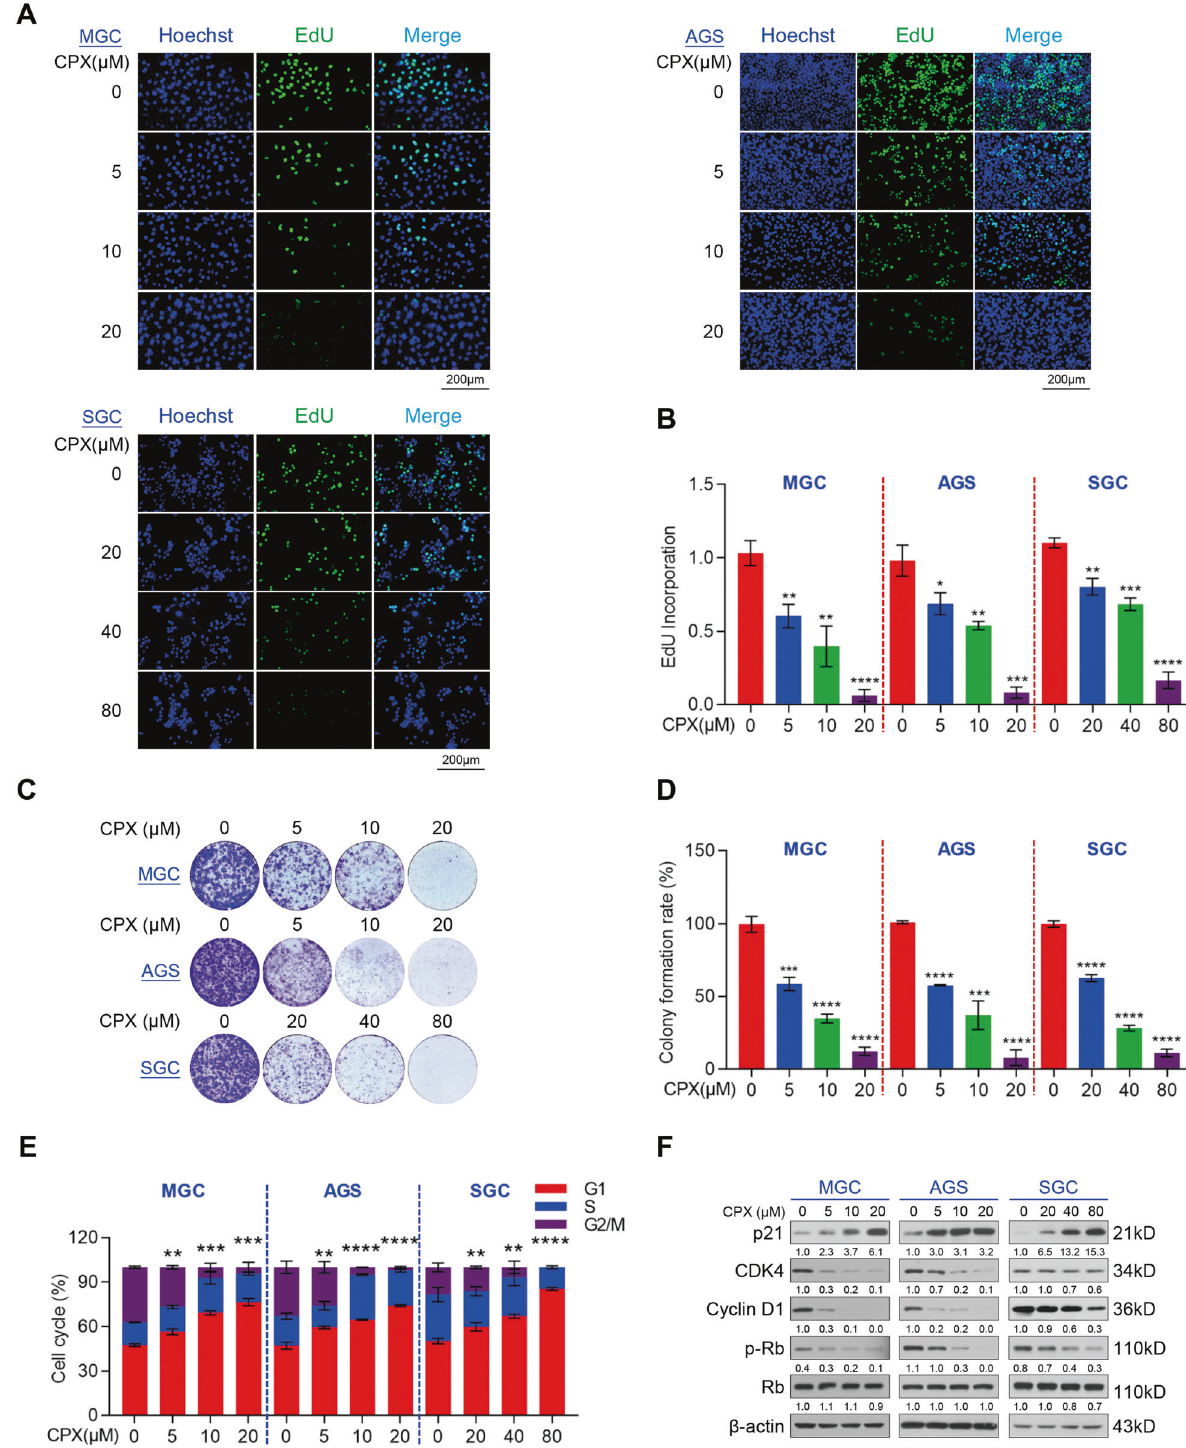
Fig. 1 CPX remarkably inhibits GC cell proliferation in vitro. A , B Proliferation of MGC, AGS, and SGC cells treated with various concentrations of CPX for 24 h. Cell proliferation was detected using an EdU cell proliferation kit with Alexa Fluor 488 (Scale bar, 200 µm) ( A ). EdU incorporation was quanti fi ed using ImageJ Plus software ( B ). Data were shown as mean ± SD ( n = 3, * P < 0.05, ** P < 0.01, *** P < 0.001, **** P < 0.0001). C , D Colony formation of MGC, AGS, and SGC cells treated with various concentrations of CPX for 1 – 2 weeks. Cell colonies were stained with 0.1% crystal violet solution ( C ). Colony numbers were counted using ImageJ Plus software ( D ). Data were shown as mean ± SD ( n = 3, ** * P < 0.001, **** P < 0.0001). E Cell cycle arrest assay analysis of MGC, AGS, and SGC cells treated with a serial dose of CPX for 24 h. The percentage of cell cycle distribution was analyzed using fl ow cytometry. Data were shown as mean ± SD ( n = 3, ** P < 0.01, *** P < 0.001, **** P < 0.0001). F The protein levels of cell cycle-related proteins were examined using Western blotting analysis.